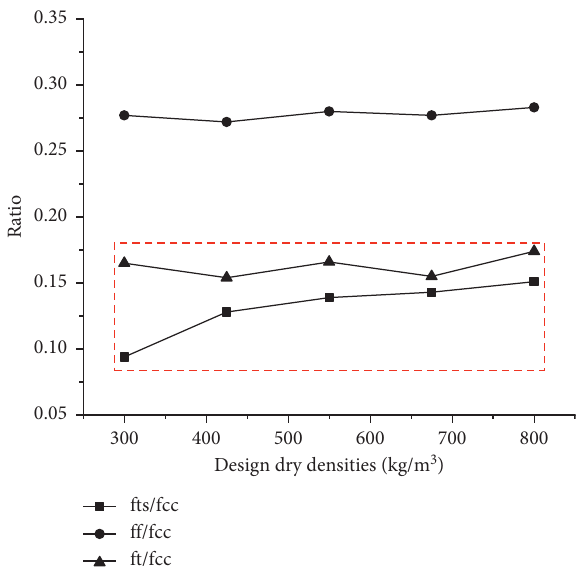
Figure 7: The ratio of tensile strength to compressive strength with dry density.